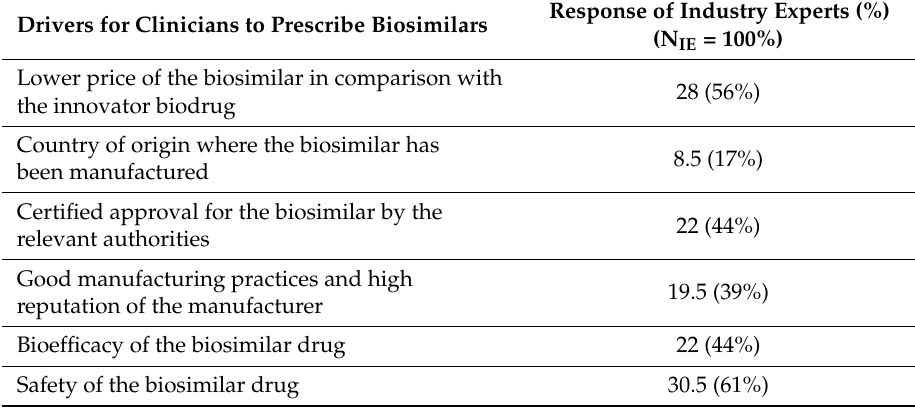
Table 4. Drivers for Clinicians to prescribe biosimilars (According to Industry